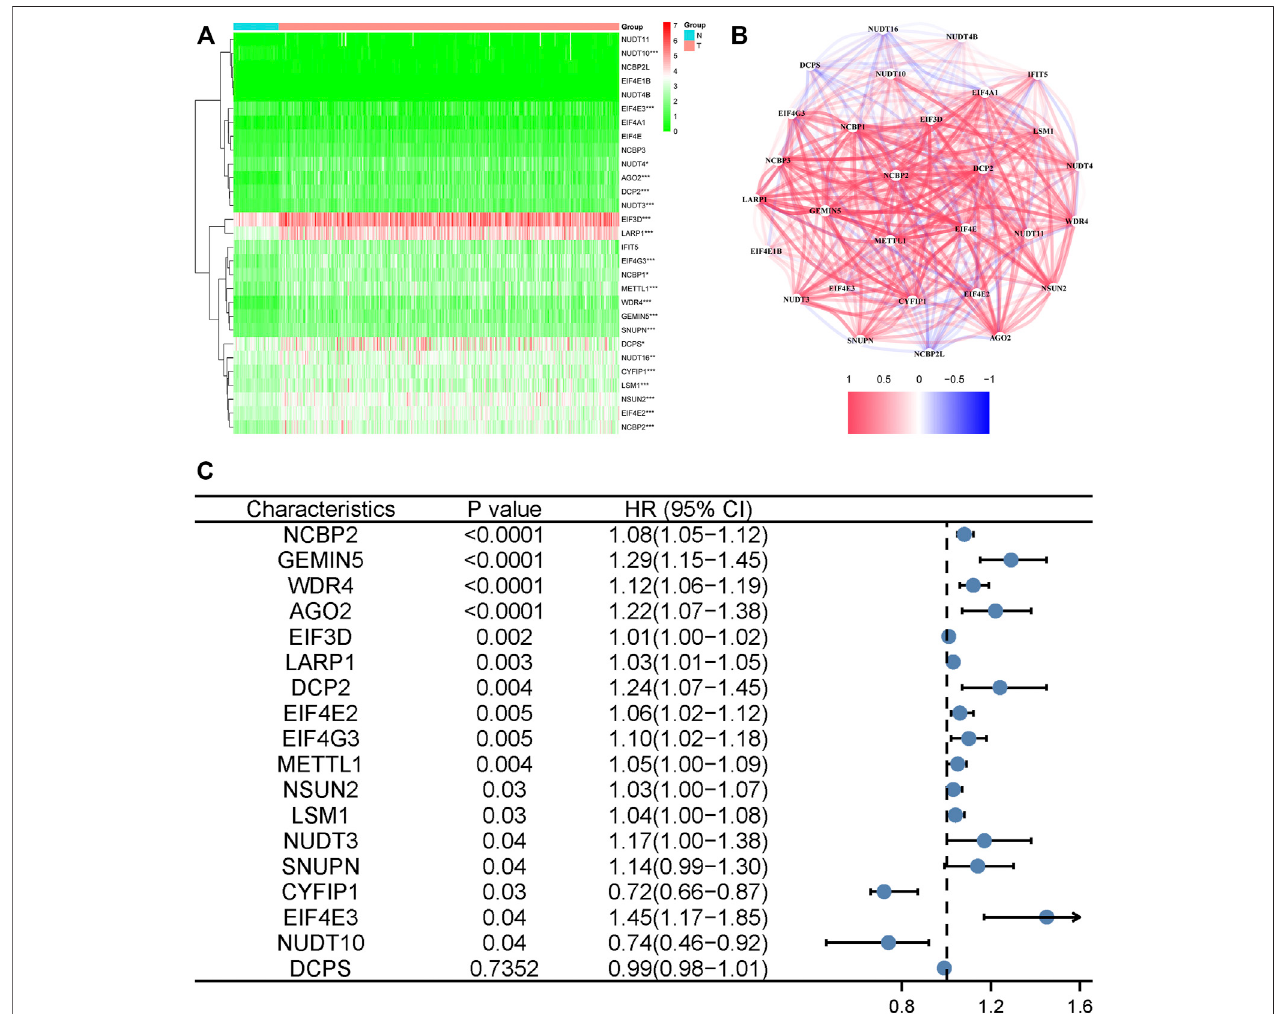
FIGURE 1 | Identi fi cation of the candidate genes. (A) Heatmap of the differentially expressed genes in the two groups. *** denotes p < 0.001, ** denotes p < 0.01, and * denotes p < 0.05. (B) The relationship between necroptosis-related differentially expressed genes. A positive correlation is indicated by red, while a negative correlation is indicated by blue. (C) Forest plots showing the results of a univariate Cox regression analysis between gene expression and overall survival.